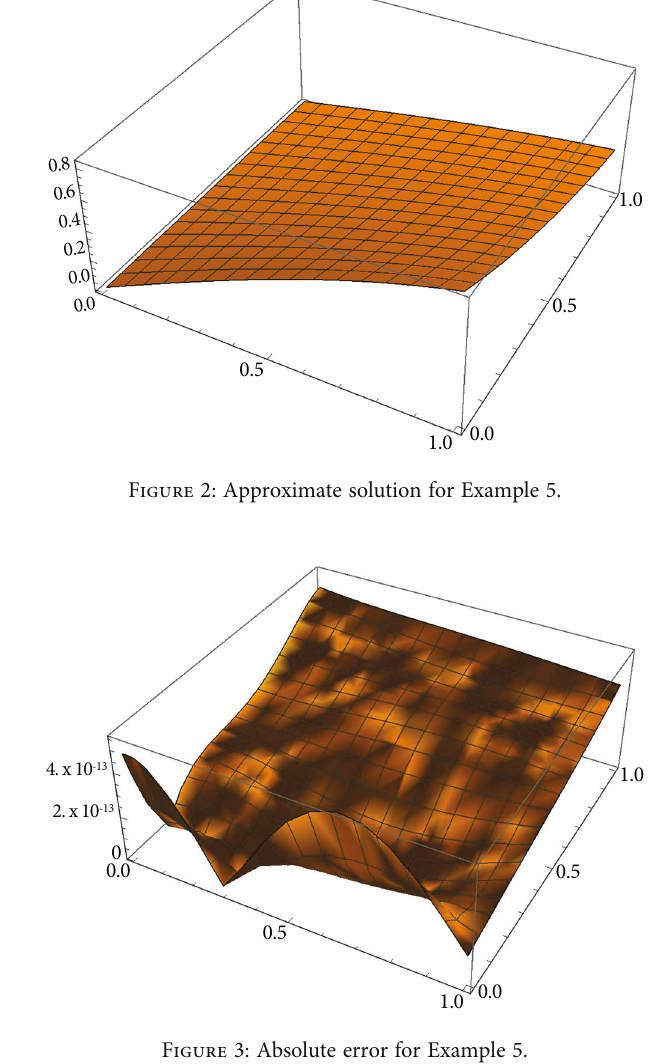
Table 2: Comparison of the MAEs of Example 5.